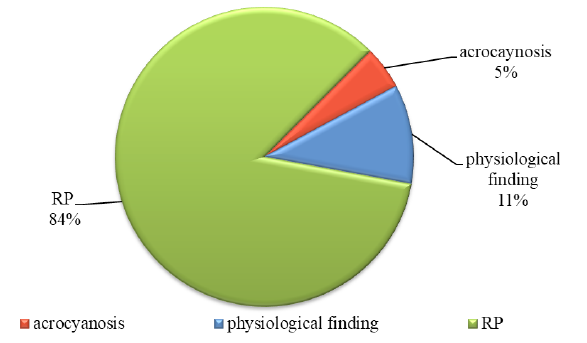
Fig. 4. Diagnosis according to IRT examination.